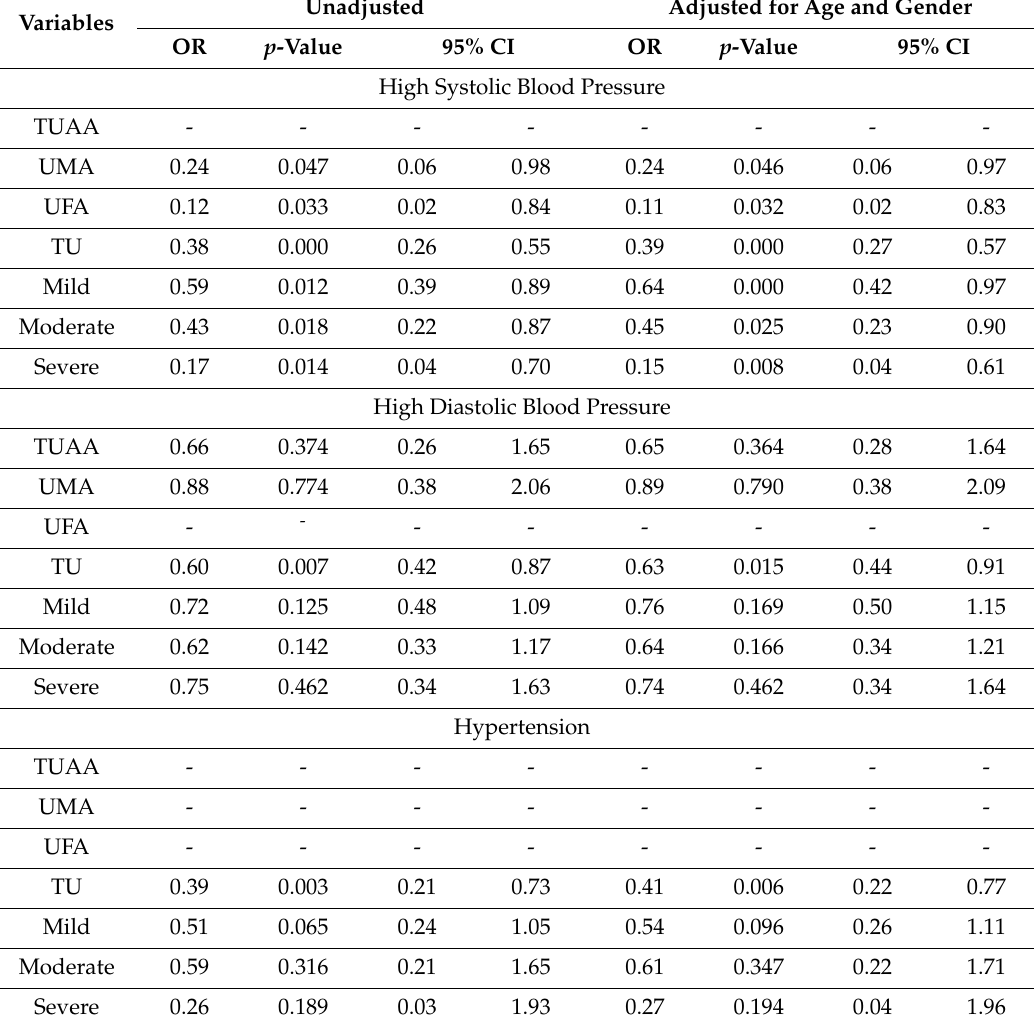
Table 3. Logistic regression with anthropometric variables as independent variables and high systolic blood pressure (SBP), high diastolic blood pressure (DBP) and hypertension as a dependent variable in the total